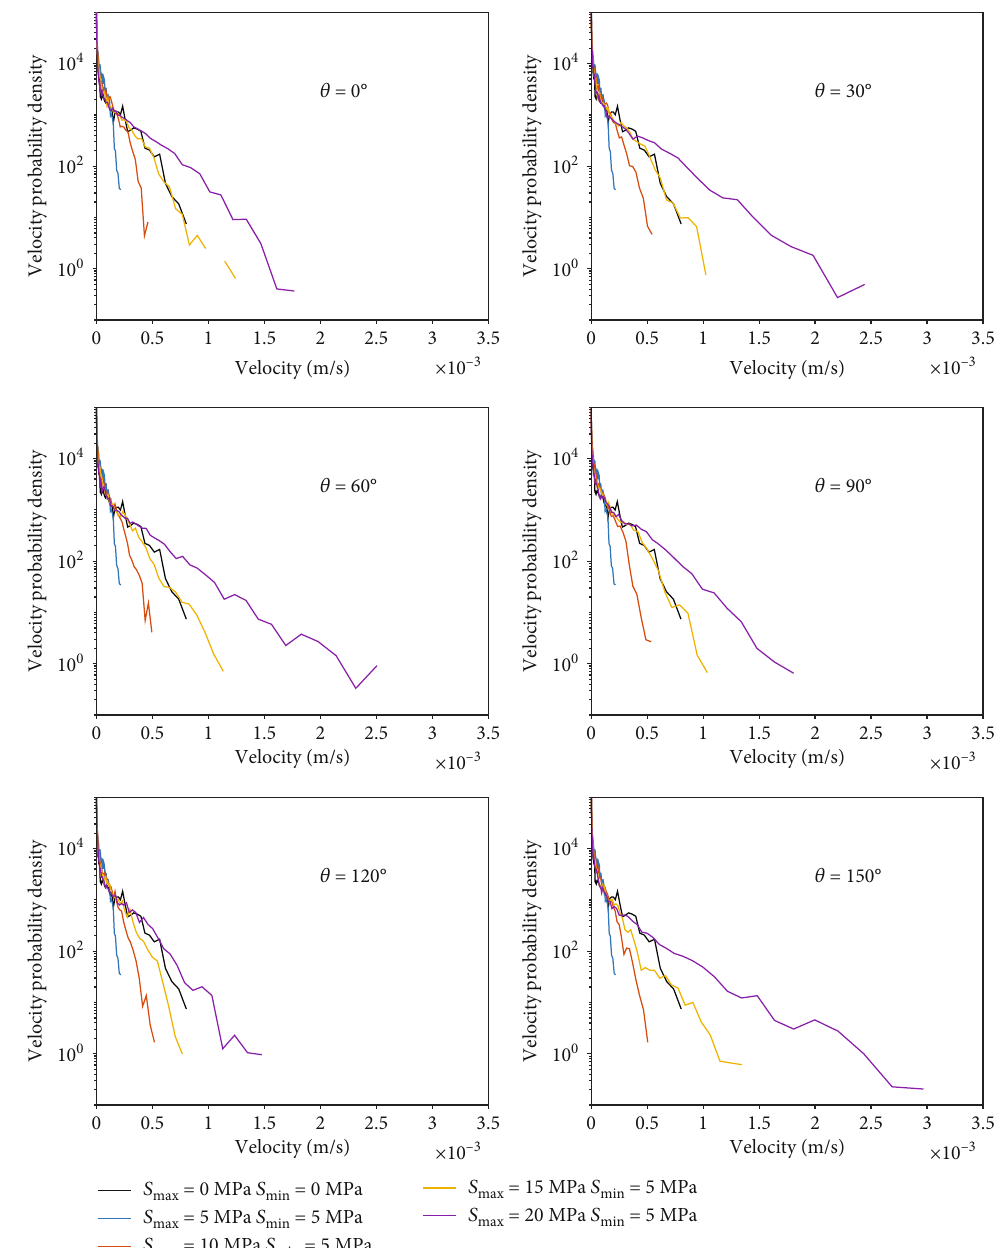
Figure 6: Probability density function of the fl ow velocity in the fracture network under various stress